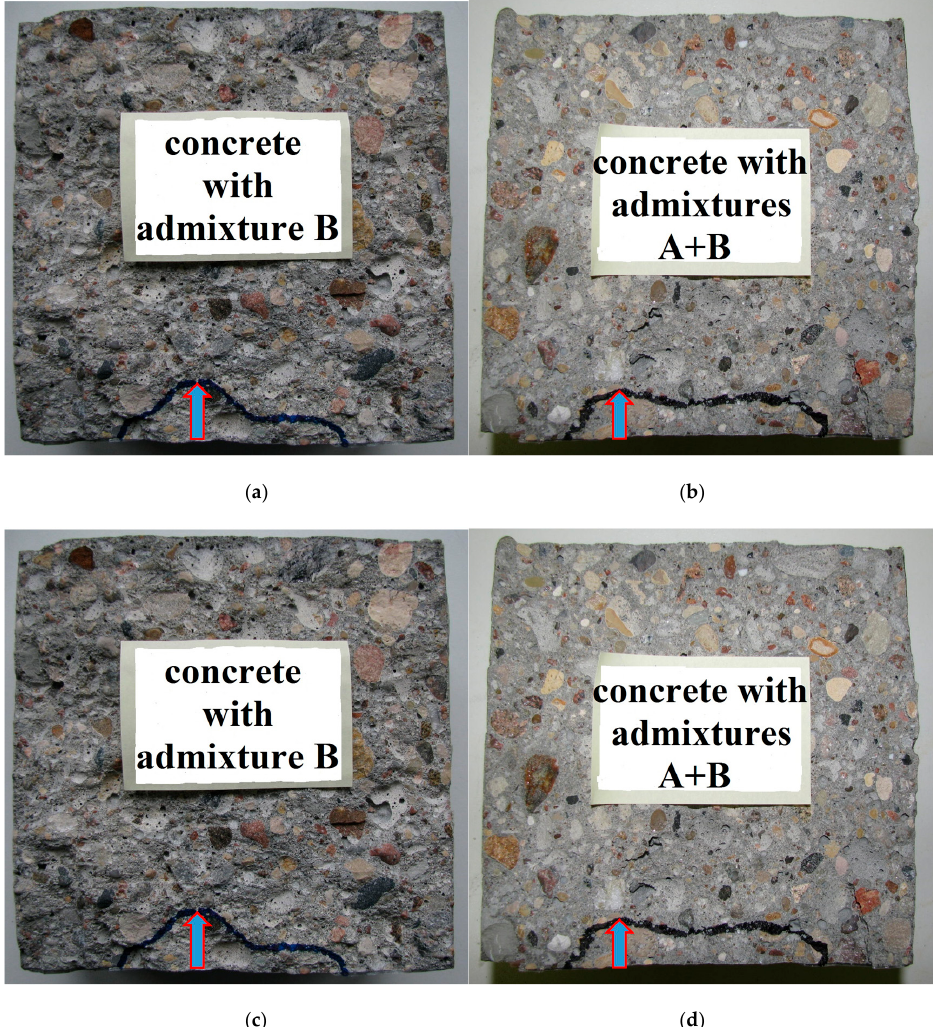
Figure 3. Cross-sections of the chosen tested specimens, which were split after testing, showing the water penetration depth of the tested specimens for the different types of concrete. ( a ) concrete without admixture, ( b ) concrete with admixture A, ( c ) concrete with admixture B, ( d ) concrete with admixture A +